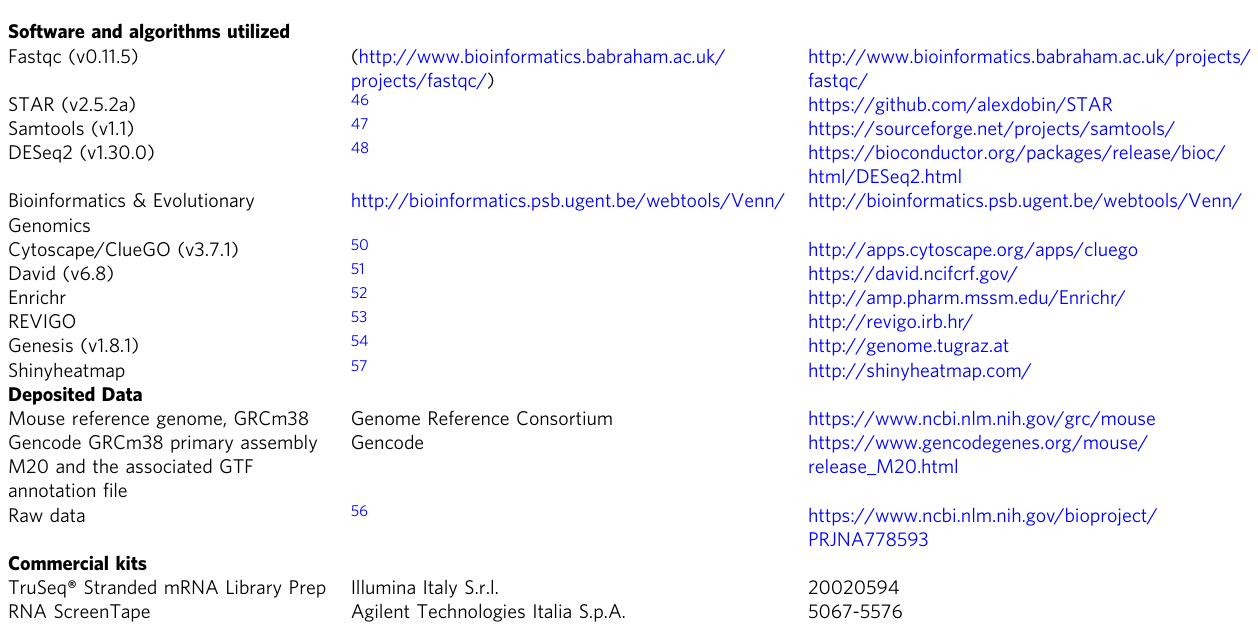
Table 1 Transcriptomics tools and deposited